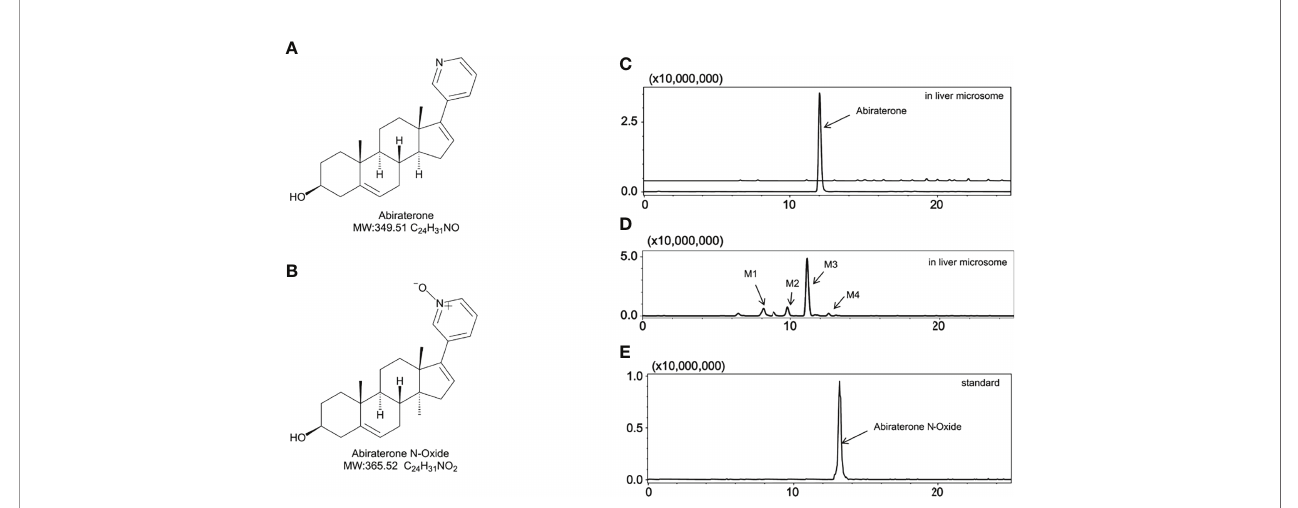
FIGURE 1 | The metabolites of Abiraterone from liver microsomes. (A) The chemical structure of Abiraterone. (B) The chemical structure of Abiraterone N-Oxide. (C) Extracted ion chromatograms (EICs) of Abiraterone after 0 min of liver microsomal metabolism. (D) EICs of metabolites of Abiraterone after 120 min of liver microsomal metabolism. (E) EICs of the standard Abiraterone